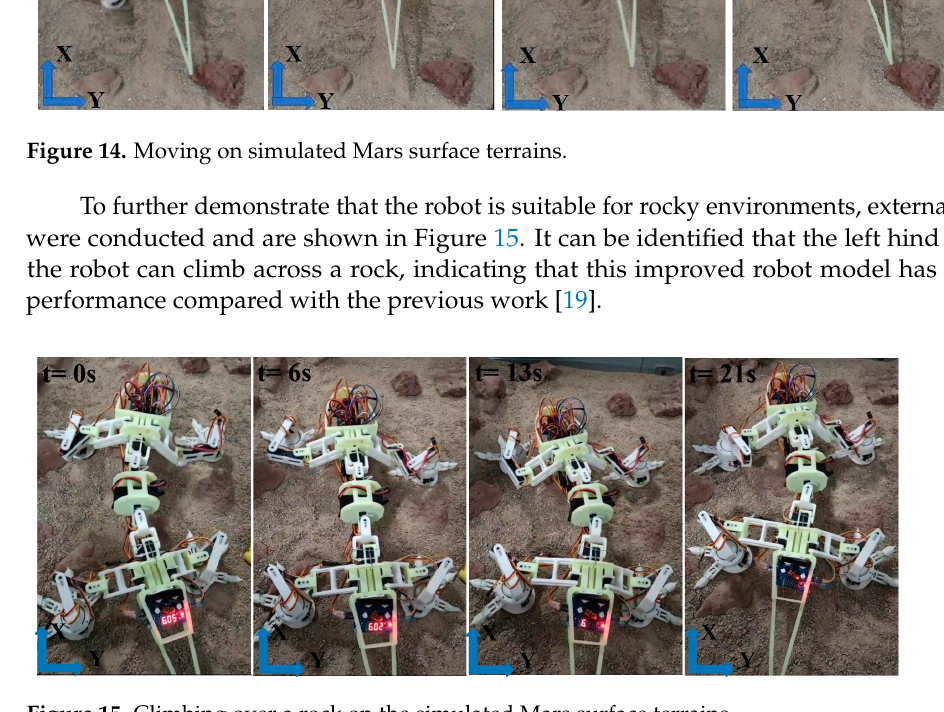
Figure 14. Moving on simulated Mars surface terrains.